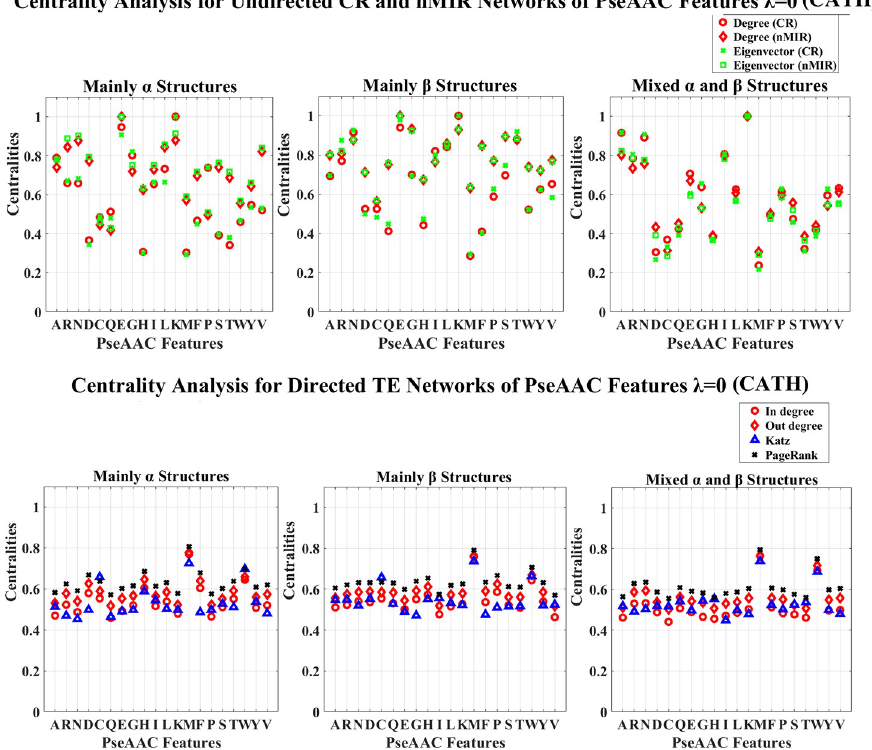
Fig 5. Centrality analysis for the networks of D features (CATH). This figure shows the centrality results for the networks of D features (CATH